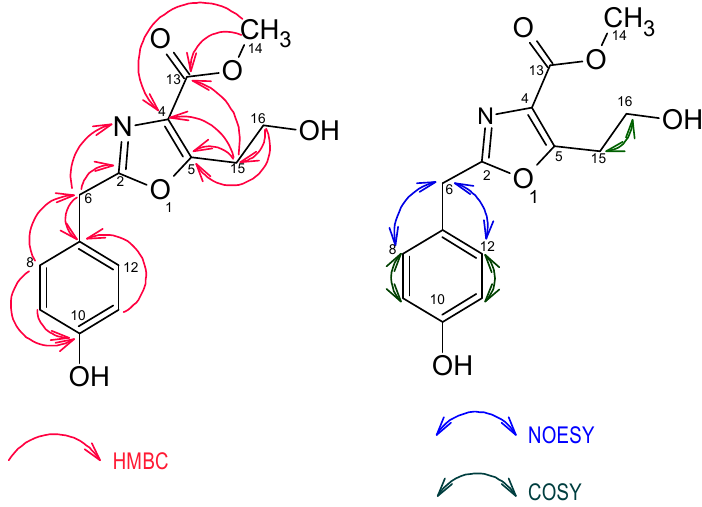
Figure 4. Key HMBC, COSY and NOESY correlations of compound 1 .